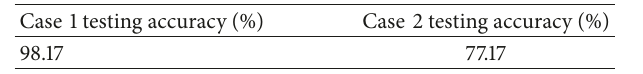
Figure 29: The diagnosis results of the OFS-FSASD-SVM model with different sfn. Table 14: Bearing fault diagnosis results obtained by the OFS-SVM.